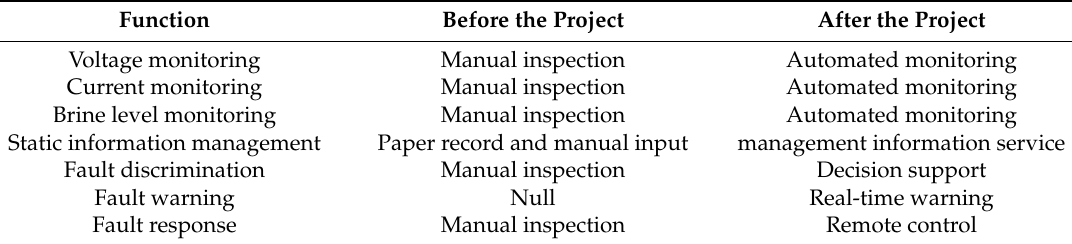
Table 10. Functional analysis before and after the implementation of the system.